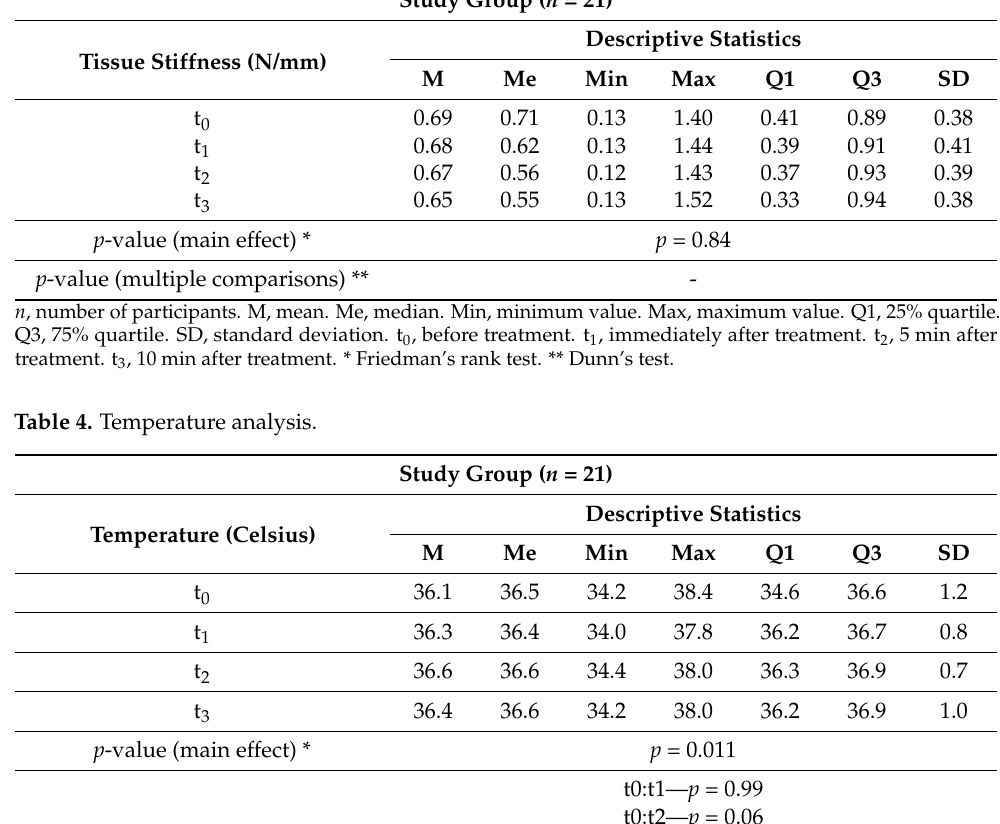
Table 3. Stiffness of the thoracolumbar fascia. Tissue Stiffness (N/mm)